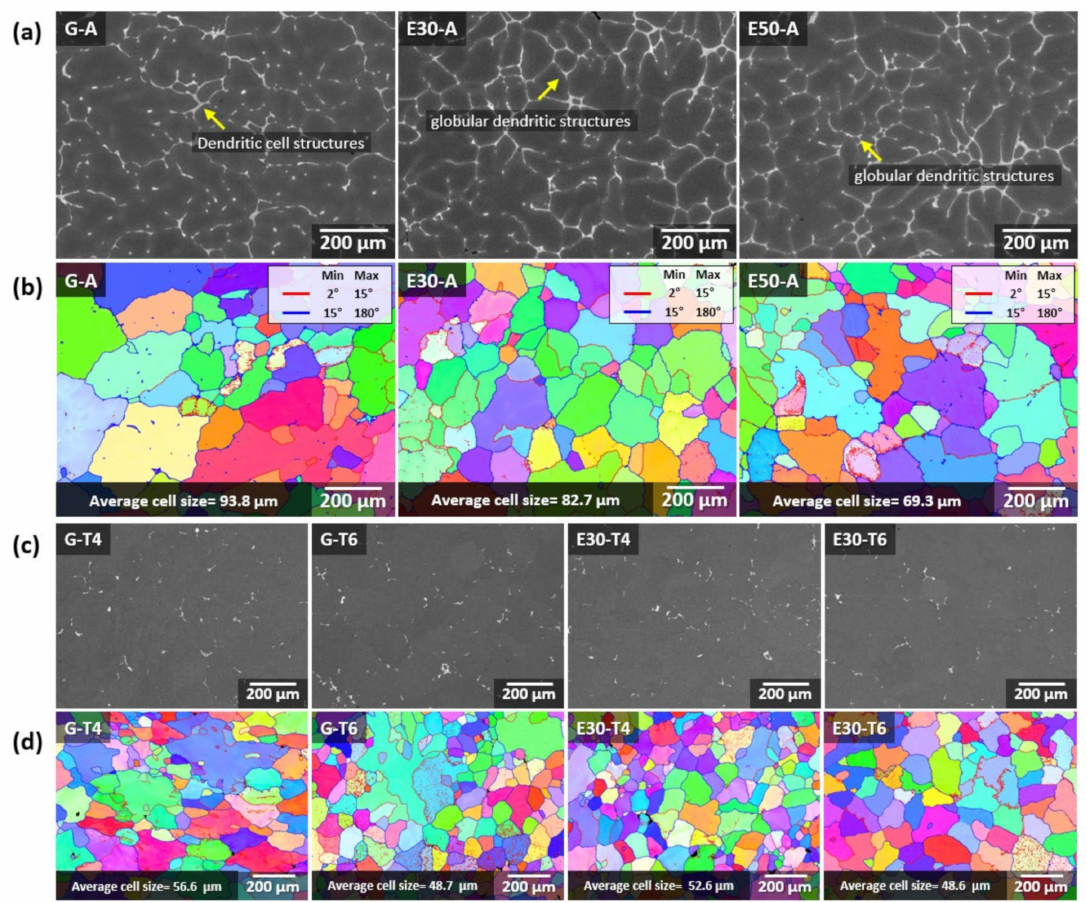
Figure 1. Microstructure analysis of the as-cast and heat-treated specimens showing the solute distribution in Al-Zn-Mg- Cu alloys. ( a ) SEM micrographs and ( b ) inverse pole figure (IPF) maps of G-A, E30-A, and E50-A specimens. ( c ) SEM micrographs and ( d ) IPF maps of T4 and T6 heat-treated specimens.